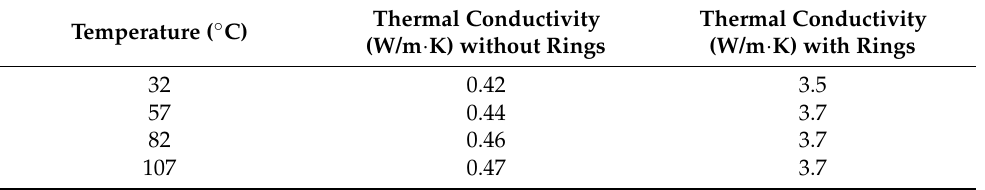
Table 2. Thermal conductivity enhancement of sodium/potassium formate PCM from Al 6061 rings.